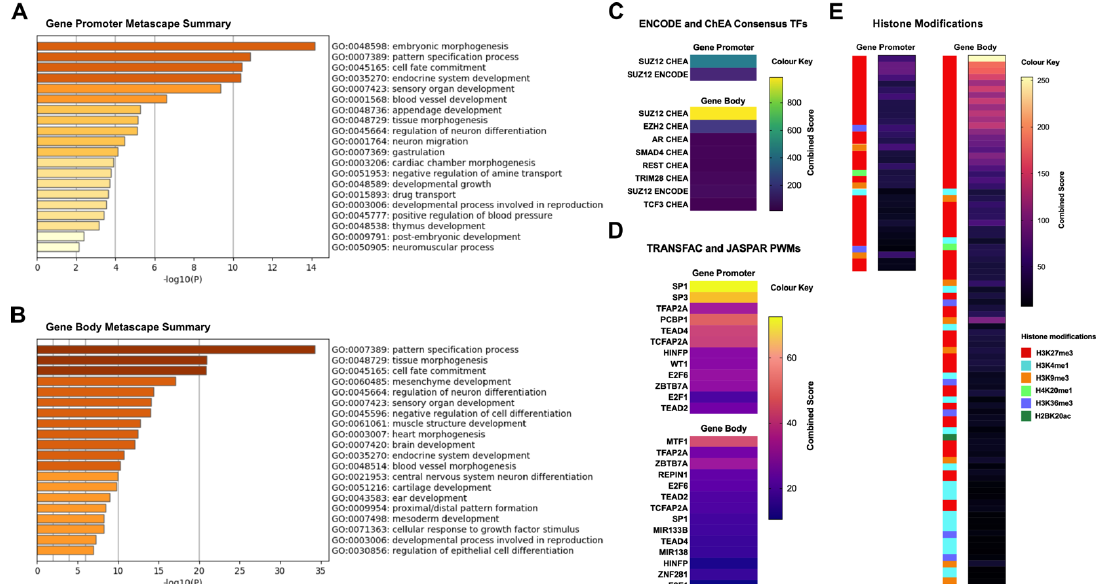
Figure 4. Analysis of differentially methylated fragments shared between tumour tissues and derived cell lines, with regard to gene enrichment and transcriptional function. ( A , B ) Enriched gene ontology terms relative to the shared DMFs that overlapped either gene promoters ( − 2 kb to +1 kb from the TSS) or gene bodies; the x axis represents − log10 of p -values. ( C – E ) Heatmaps of transcription factor (TF) targets (ENCODE/ChEA, TRANSFAC/JASPAR positional weight matrices) and histone modifications (Epigenomics Roadmap) significantly enriched (adjusted p -value < 0.01) in gene promoter and gene body DMFs.